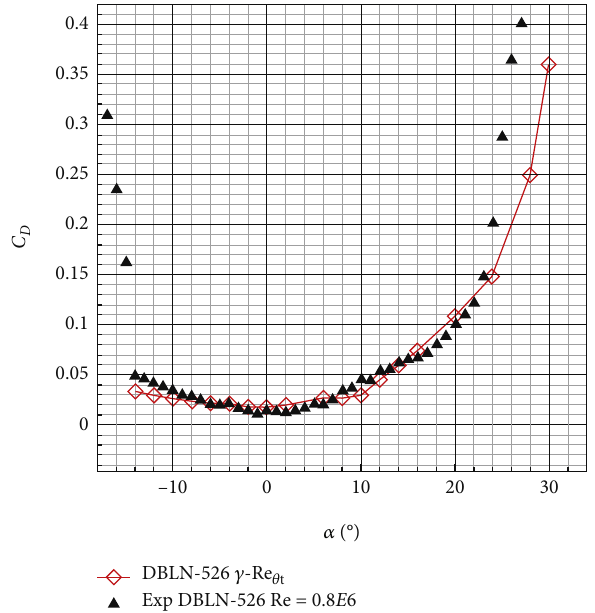
Figure 11: Drag coe ffi cient of DBLN-526 airfoil ( Re = 0 : 8 E 6 ).